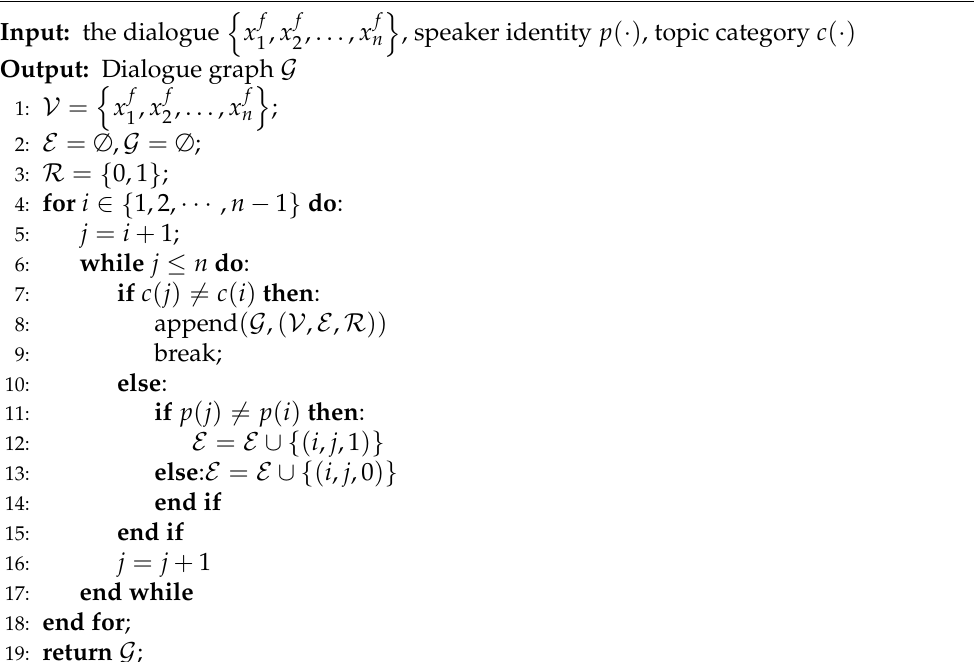
Algorithm 2 conversation subgraph construction